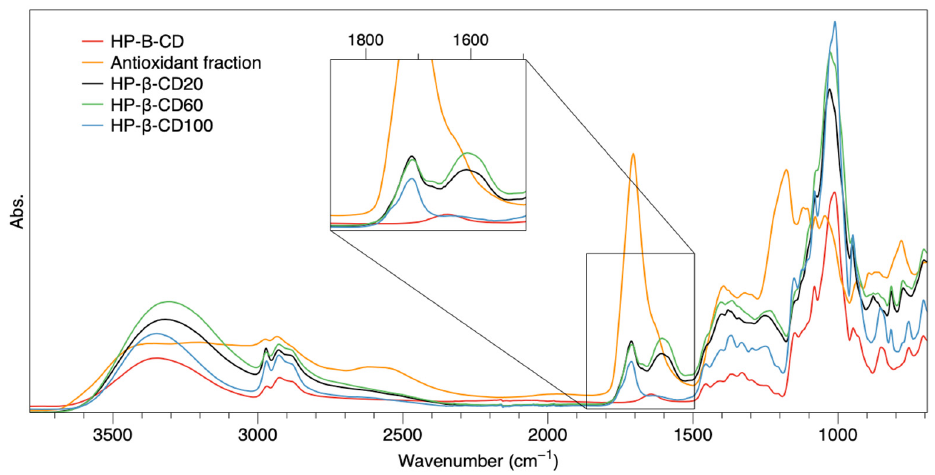
Figure 4. FTIR spectra of antioxidant fraction (orange), HP- β -CD (red), and inclusion complexes HP- β -CD20, HP- β -CD60, and HP- β -CD100 (black, green, and blue, respectively).